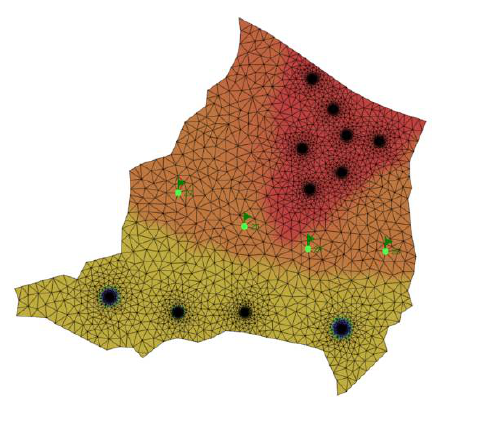
Figure 3. Temperature effects during the transience period (1350 days): ( a ) global temperature distribution; ( b ) local temperature distribution around an injector.